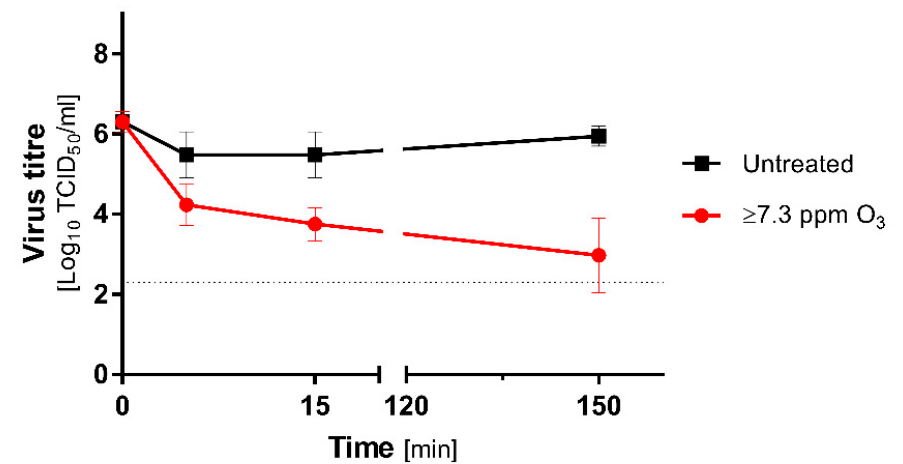
Figure 1. Inactivation of MHV diluted in PBS during the ozone treatment at 21.8% RH. The ozone concentration was measured from t = 60 min, and it exceeded detector measuring range, i.e., 7.3 ppm. Virus titers were calculated as a mean ( ± SD): n = 2 in the untreated group and n = 6 in the treated group. Red line represents the samples subjected to ozone treatment; the black line corresponds to untreated control. The horizontal dotted line represents 4 logs virucidal efficiency with respect to the initial titre.